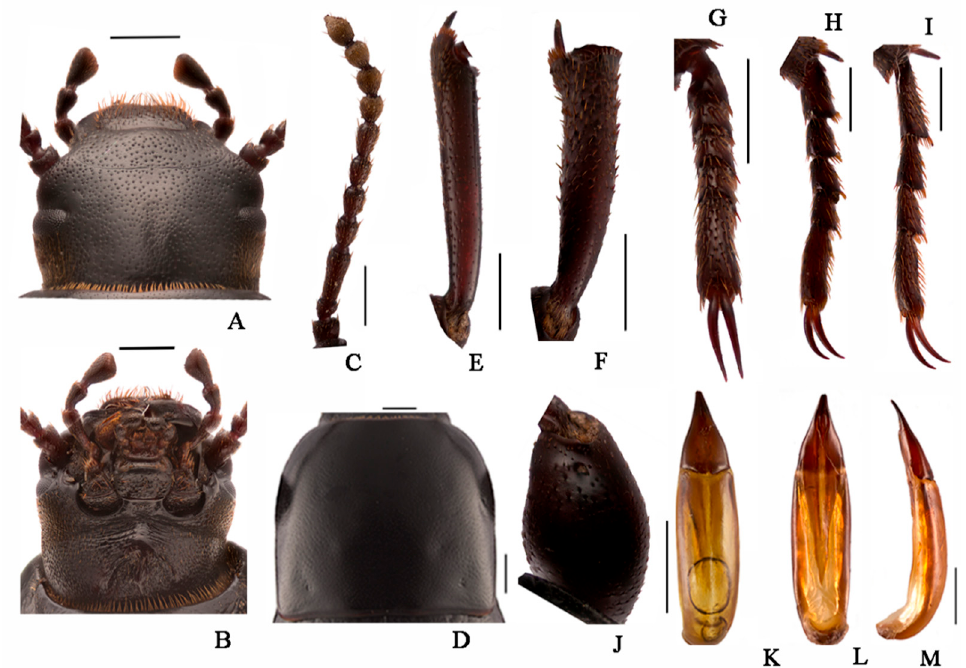
Figure 11. Nalepa yushuensis sp. n. ( A ). head, dorsal view; ( B ). head, ventral view; ( C ). antenna; ( D ). pronotum; ( E ). protibia; ( F ). mesotibia; ( G ). protarsus; ( H ). mesotarsus; ( I ). metatarsus; ( J ). profemora; ( K – M ). aedeagus: ( K ). dorsal view; ( L ). ventral view; ( M ). lateral view. Scale bars: 1.0 mm.